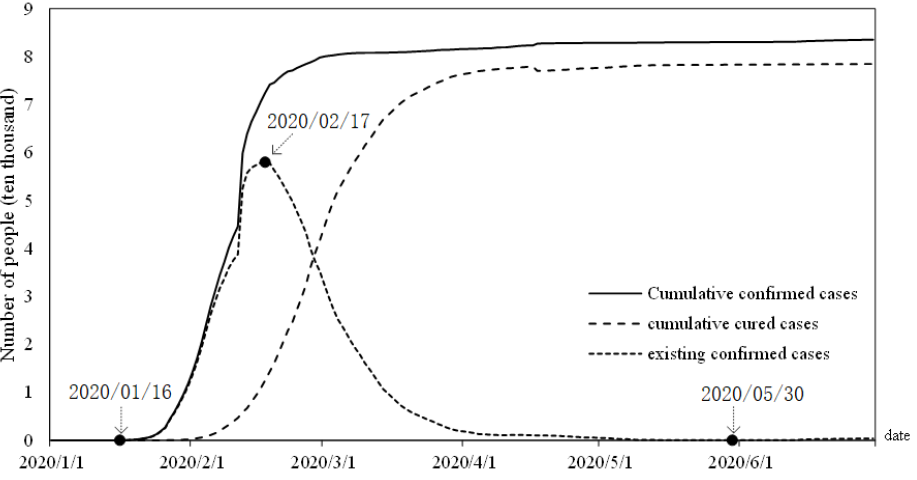
Figure 5. Trends of COVID-19 in China from January to June 2020. Data source: National Health Commission of the People’s Republic of China.